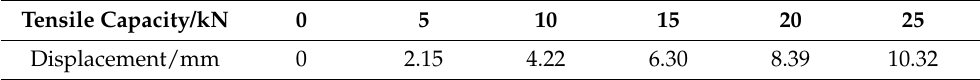
Table 2. Finite element analysis of the eccentric tension on the sockets on the horizontal bar. Tensile Capacity/kN